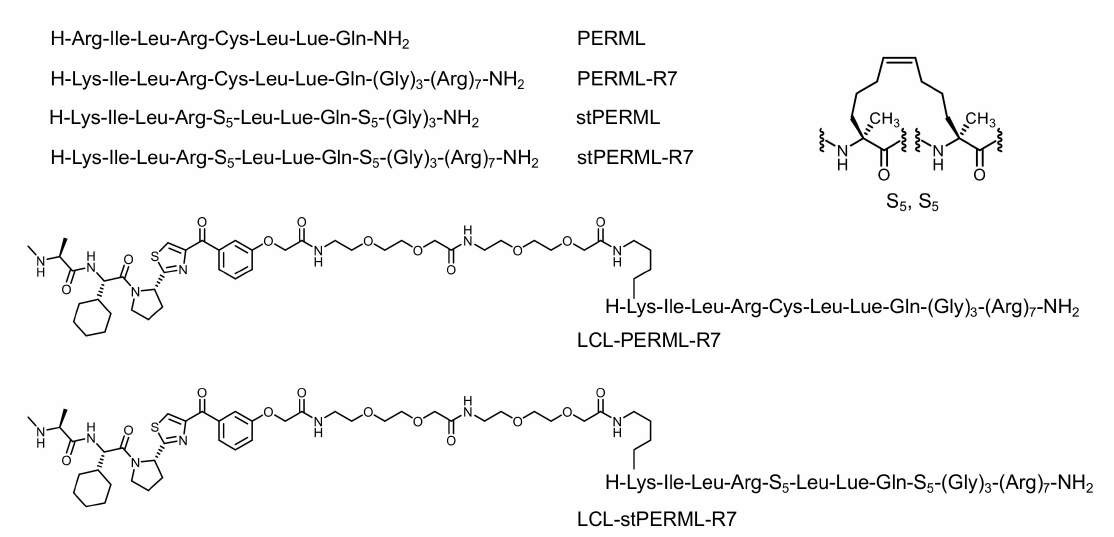
Figure 2. The design of peptides in this study. R7 (hepta-arginine) is a cell-penetrating peptide. LCL (LCL-161) is a IAP ligand. To develop chimeric degraders, LCL-161 was conjugated to the ε -amino group of the N-terminal Lys residue of PERML and stPERML via an ethylene glycol-based linker, respectively. Combinations of ( S )-pentenyl alanine (S 5 ) are used for different positions of stapling the hydrocarbon linker, and employing S 5 , S 5 at position i / i + 4 is the most common stapling position on the same face of helix